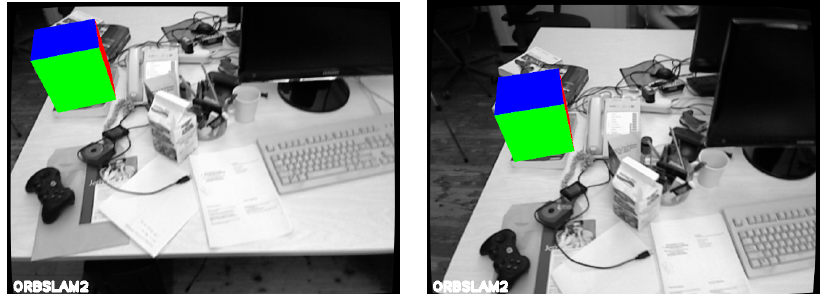
Figure 5. Illustration of an augmentation from our Fusion system on the TUM fr 1/ xyz sequence. The left and right images are taken at different moments of the augmented